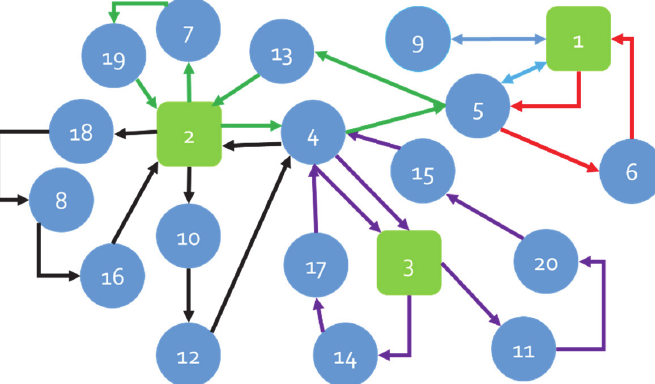
Fig. 4. Distribution route of period